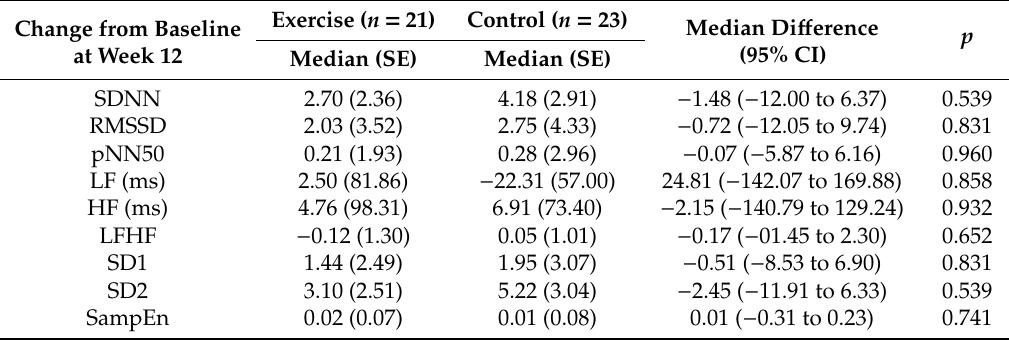
Table 5. Per-protocol (primary) analyses assessing the e ff ects of 12-week progressive aerobic exercise on HRV derived parameters in women with systemic lupus erythematosus (participants in the exercise group were included if attendance was ≥